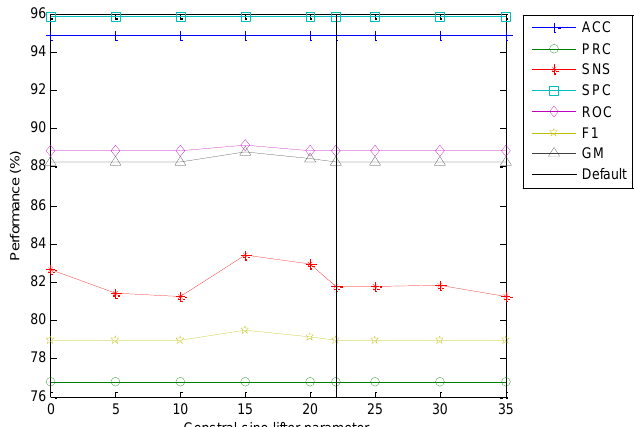
Figure 28. Classification performance metrics of the best classifier vs. the value of the cepstral lifter parameter.